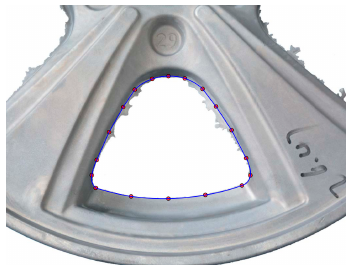
Figure 13. Target curve of disc and discrete points.